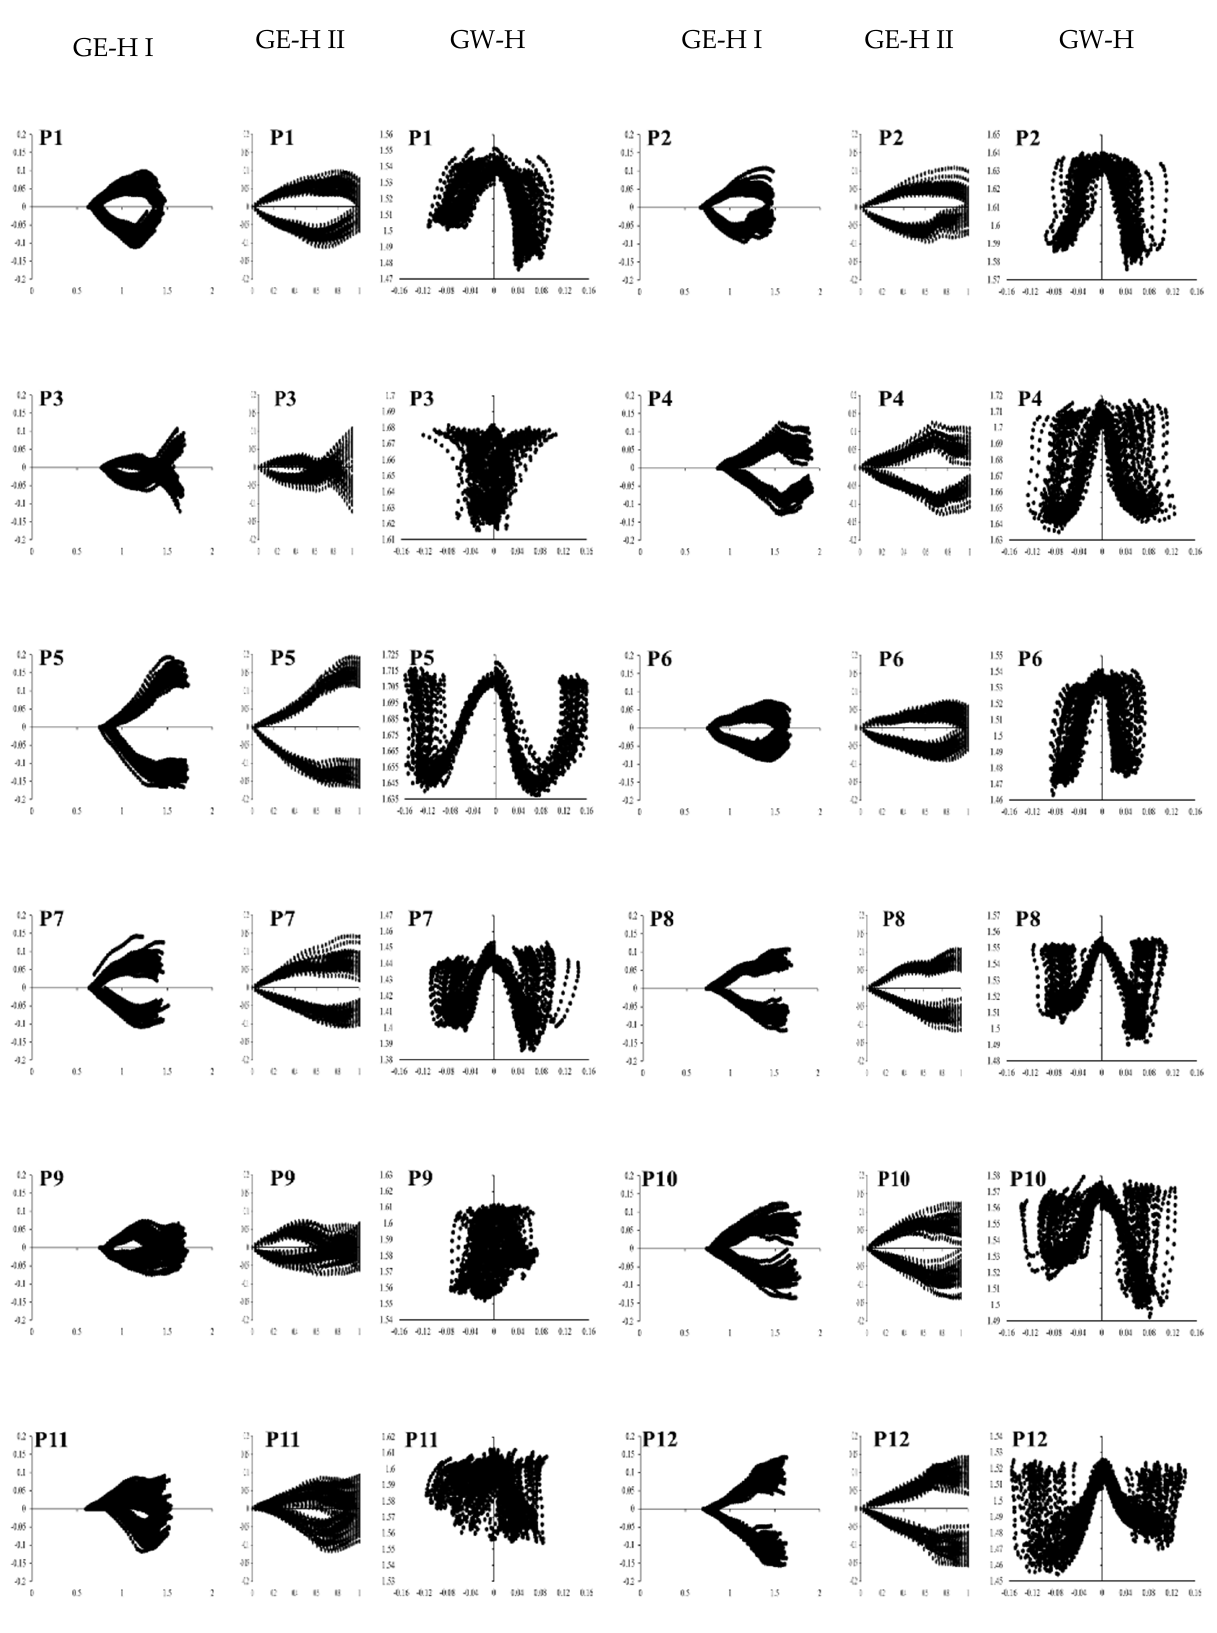
Figure 7. The gait eye diagrams at the head ( x ′ - y ′ , GE-H I), normalized eye diagrams ( x ′′ - y ′ , GE-H II) and the gait W-diagrams ( y ′ - z, GW-H ) of 12 participants (P1–P12).